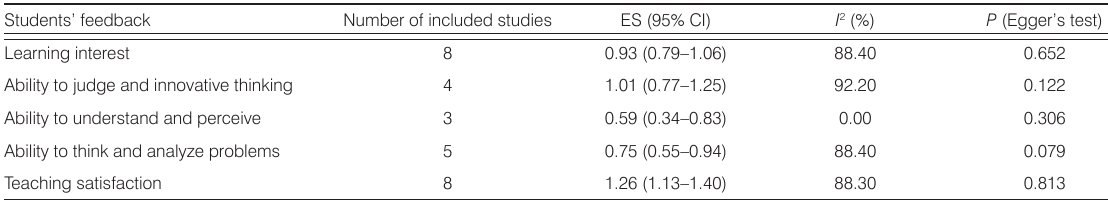
Table 3. The result of the secondary outcome